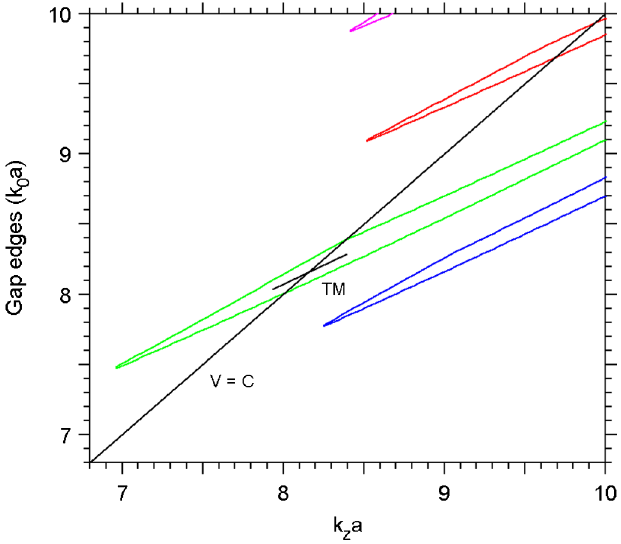
FIG. 2. The lowest band gaps near the light line ( v ¼ c ) for the Lin fiber plotted on the frequency vs wave number dispersion plane as calculated with BANDSOLVE . When a defect hole of the correct size is introduced, a TM mode with dispersion line crossing the light line appears in the band